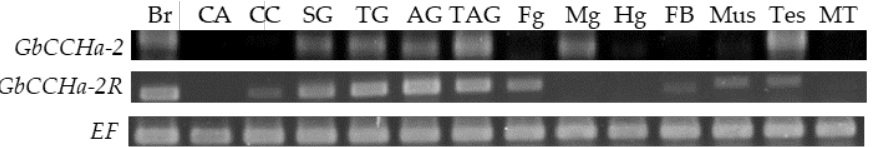
Figure 1. RT-PCR analyses of the tissue distributions of GbCCHa-2 and - 2R in male eighth-instar nymphs. Elongation factor ( EF ) was used as the internal control gene. No-RT negative control and no-template control yielded no amplification products (Supplementary Materials, Figure S1). Br, brain;